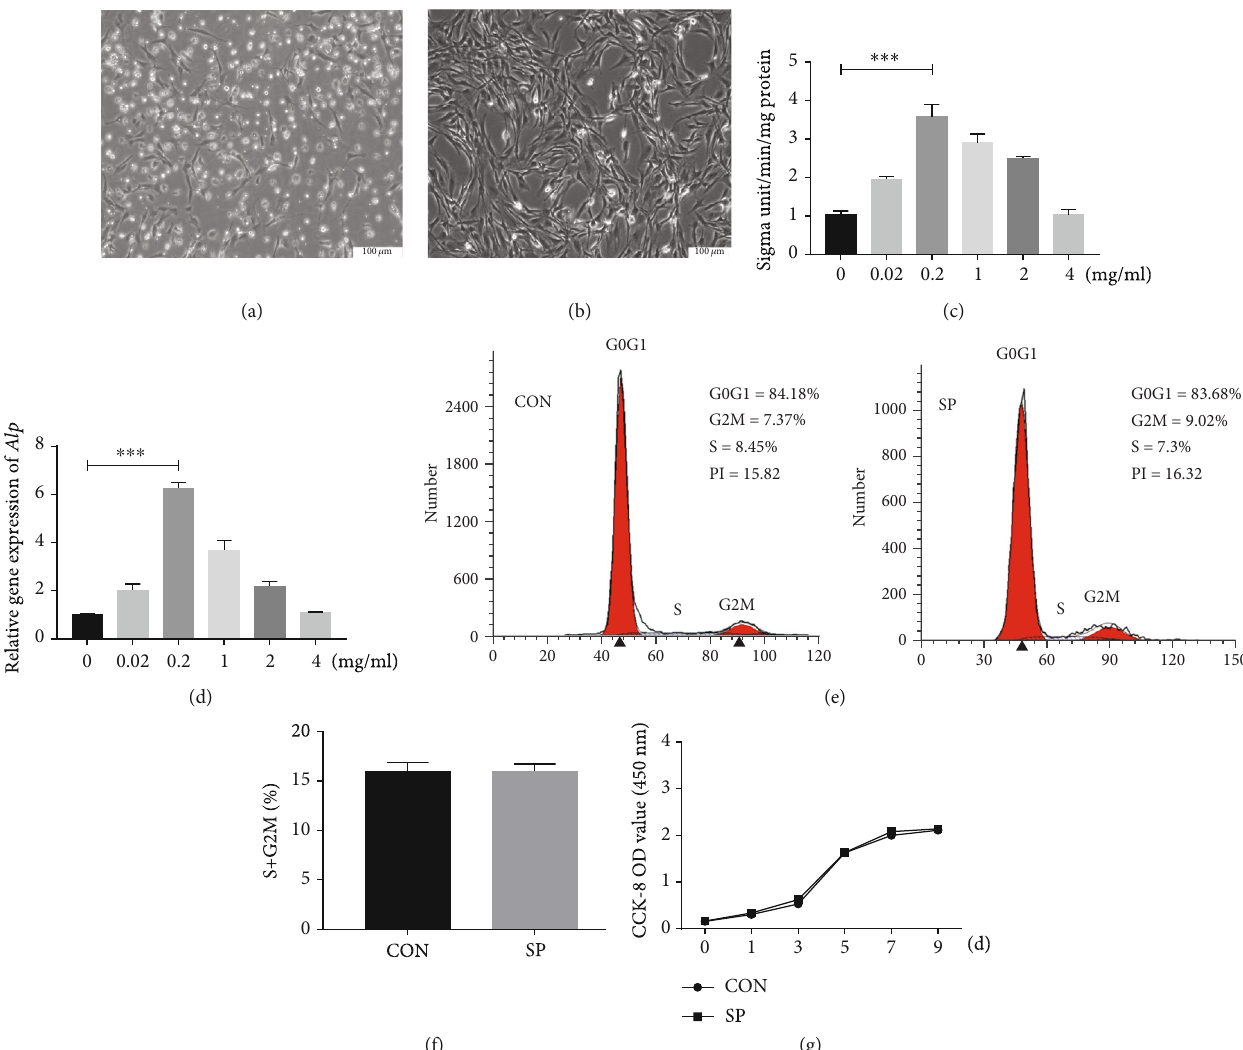
Figure 1: Optimum dose and e ff ects of iRoot SP on BMSC proliferation. (a) Primary BMSCs with fi broblast- or spindle-like morphology. (b) Cells in passage 3. Scale bar = 100 μ m . (c) ALP activity of BMSCs cultured with di ff erent concentrations of SP at day 5. ∗∗∗ p < : 001 . (d) iRoot SP at 0.2mg/ml greatly promoted the ALP mRNA expression in BMSCs after 5 days compared with the control group. ∗∗∗ p < : 001 . (e, f) Flow cytometry (FCM) analysis for control and SP-treated BMSCs. (g) After 9 days, the CCK-8 assay showed no remarkable di ff erences in cellular proliferation between 0.2mg/ml SP-treated BMSCs and untreated